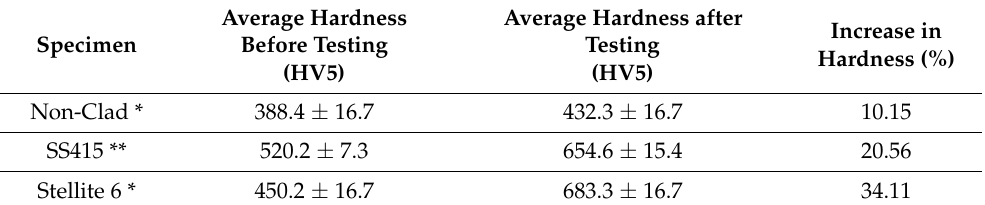
Table 6. Hardness for non-clad and cladded hypereutectoid rails before and after testing [10,12].